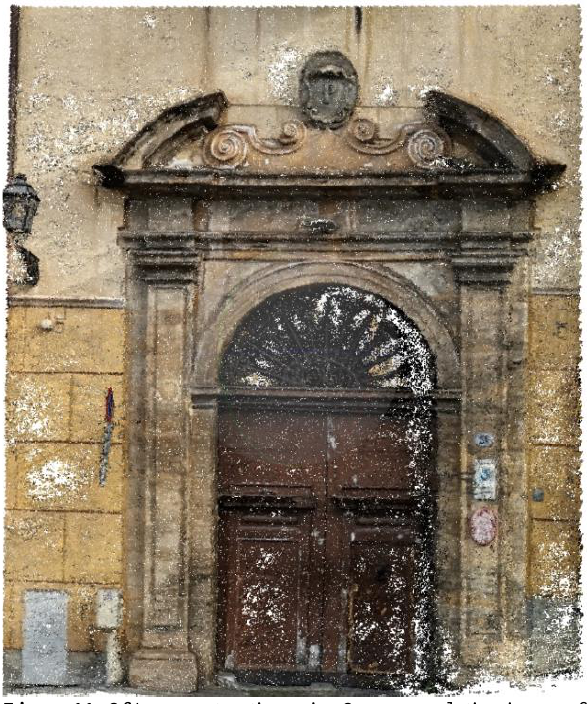
Figure 10: SfM reconstruction using low- resolution image of the portal of the façade of the ancient building. Dense Cloud